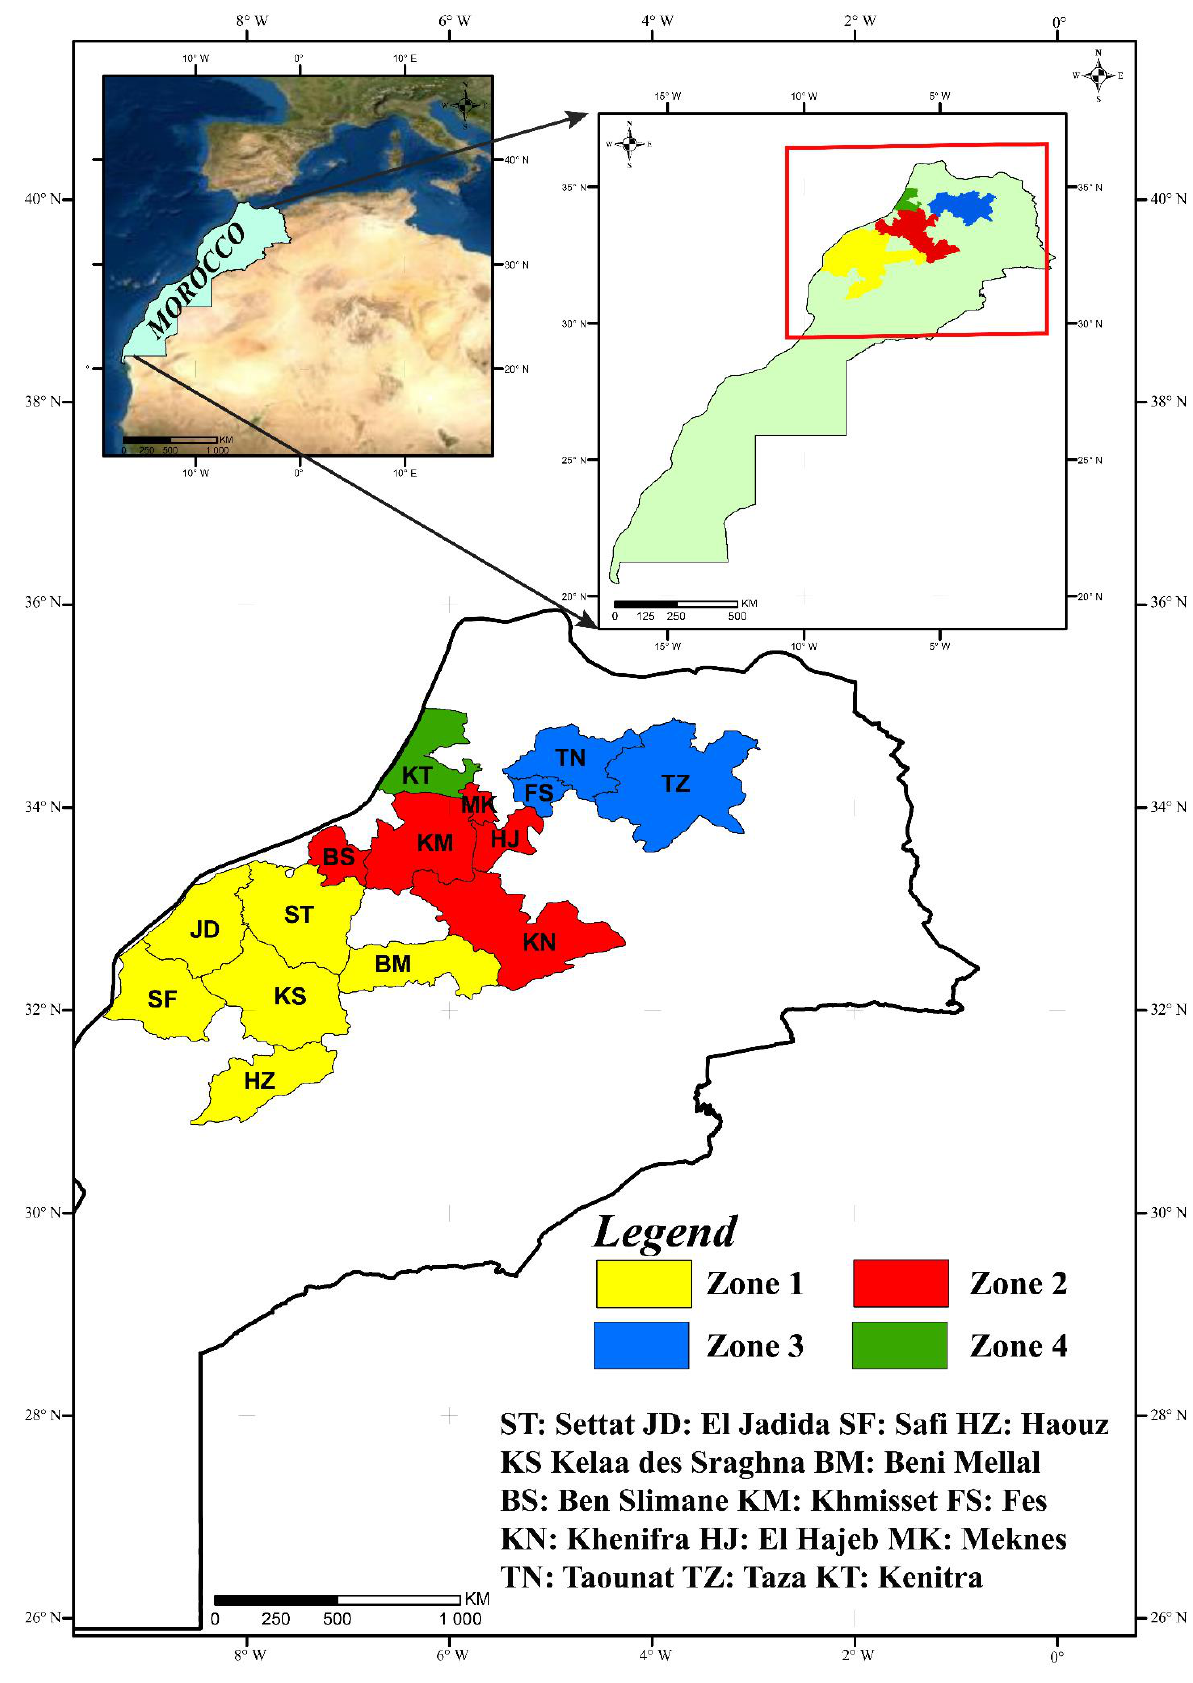
Figure 1. The study areas with the 15 provinces.